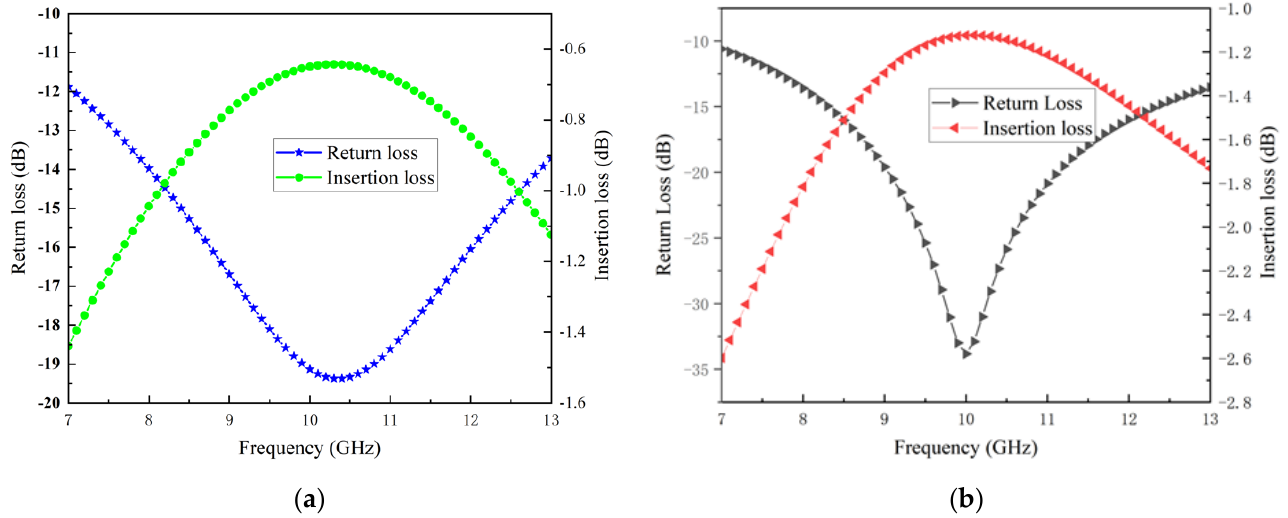
Figure 11. Return loss and insertion loss of the ( a ) ISMN; ( b ) IMN.